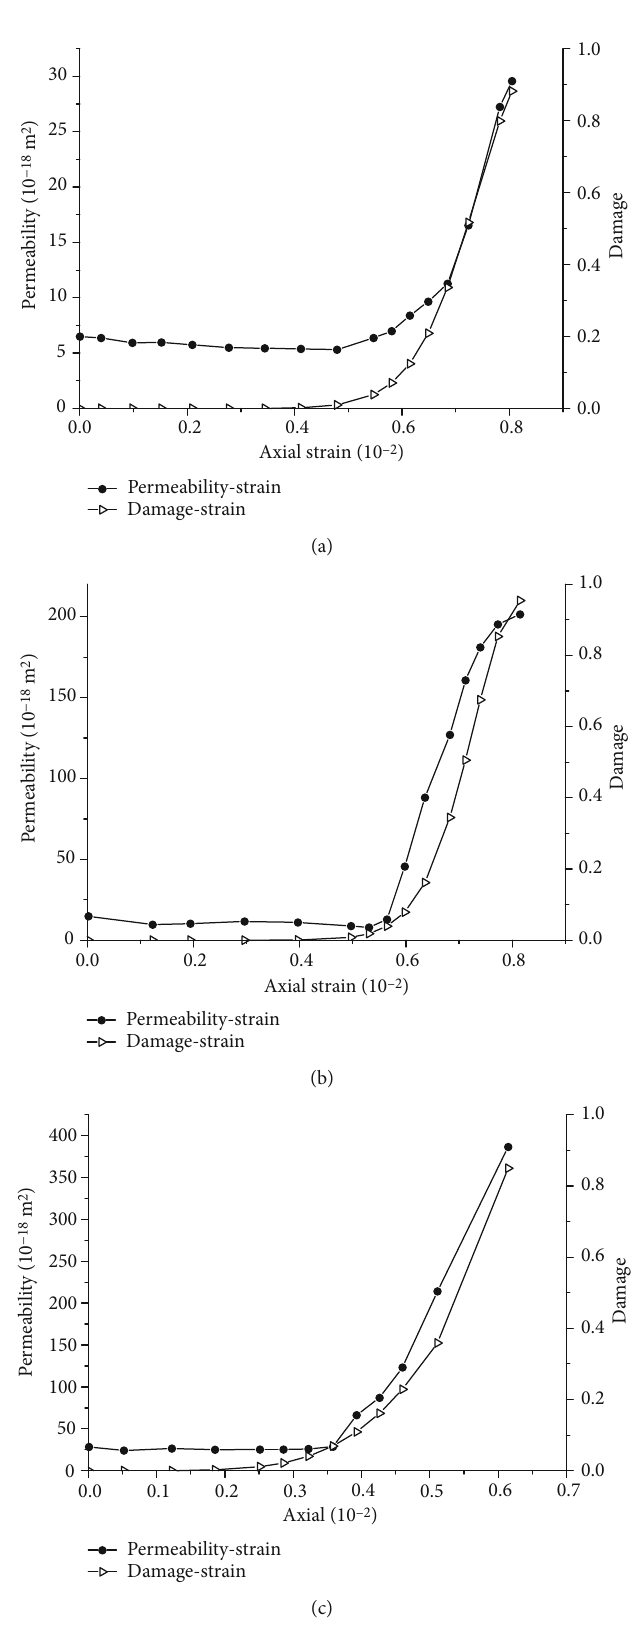
Figure 4: The permeability and damage coe ffi cient of the shale rocks vs. axial strain considering hydrated days. The labels in Fig.4 are as follows,(a) 2 days (b) 5 days (c) 10